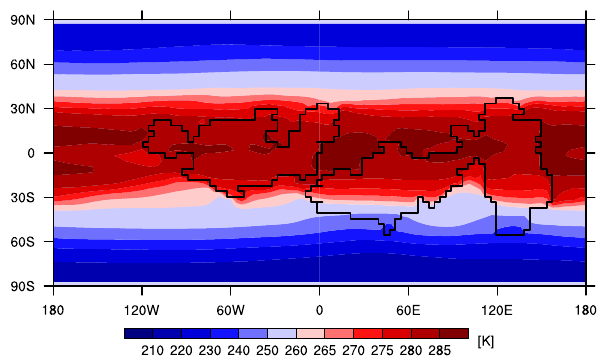
Fig. 8. Annual-mean surface temperature in K of simulation TSI96 averaged over years 6000 to 6199. Contour spacing is 5K above 260K and 10K below